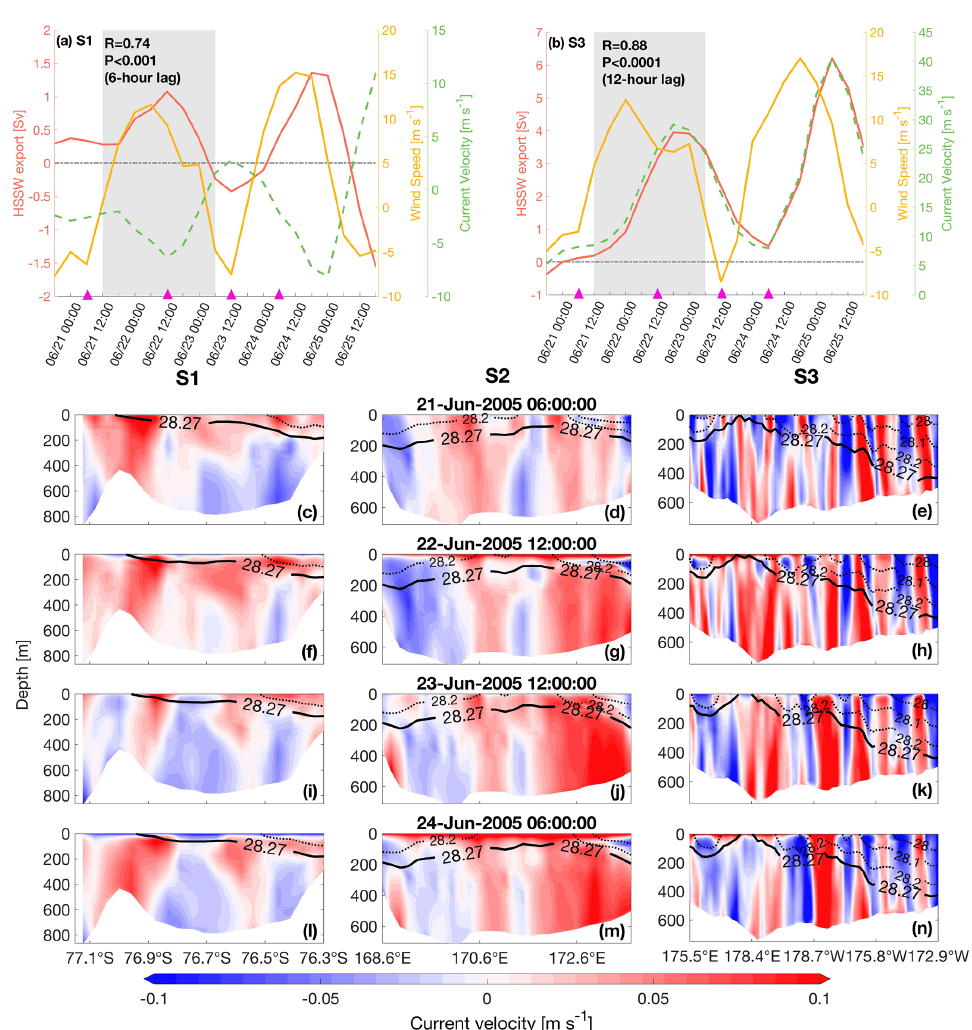
Figure 11. (a) Time series of averaged meridional winds along the S1 transect (see Fig. 1), HSSW exports across the S1, and averaged current velocity along the S1 from 18:00 on 20 June to 18:00 on 25 June 2005. The gray shading represents the time of the MESO event. The correlation coefficient R and P value were calculated between the HSSW export and meridional winds. (b) Same as panel (a) but for S3. (c–n) Vertical sections of cross-transect current velocity (colored shading) and neutral density (contour lines) on (c, f, i, l) S1, (d, g, j, m) S2, and (e, h, k, n) S3 at four selected time moments (indicated by the magenta triangles in panels a and b ). Positive values denote eastward currents for S1 and northward currents for S2 and S3. The bold black contour line indicates the neutral density contour of 28.27kgm − 3